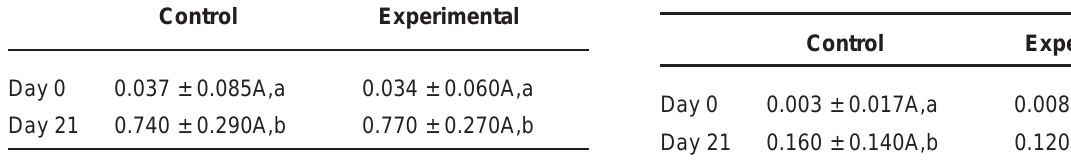
*means followed by the same uppercase letters on day 0 and day 21 do not differ statistically